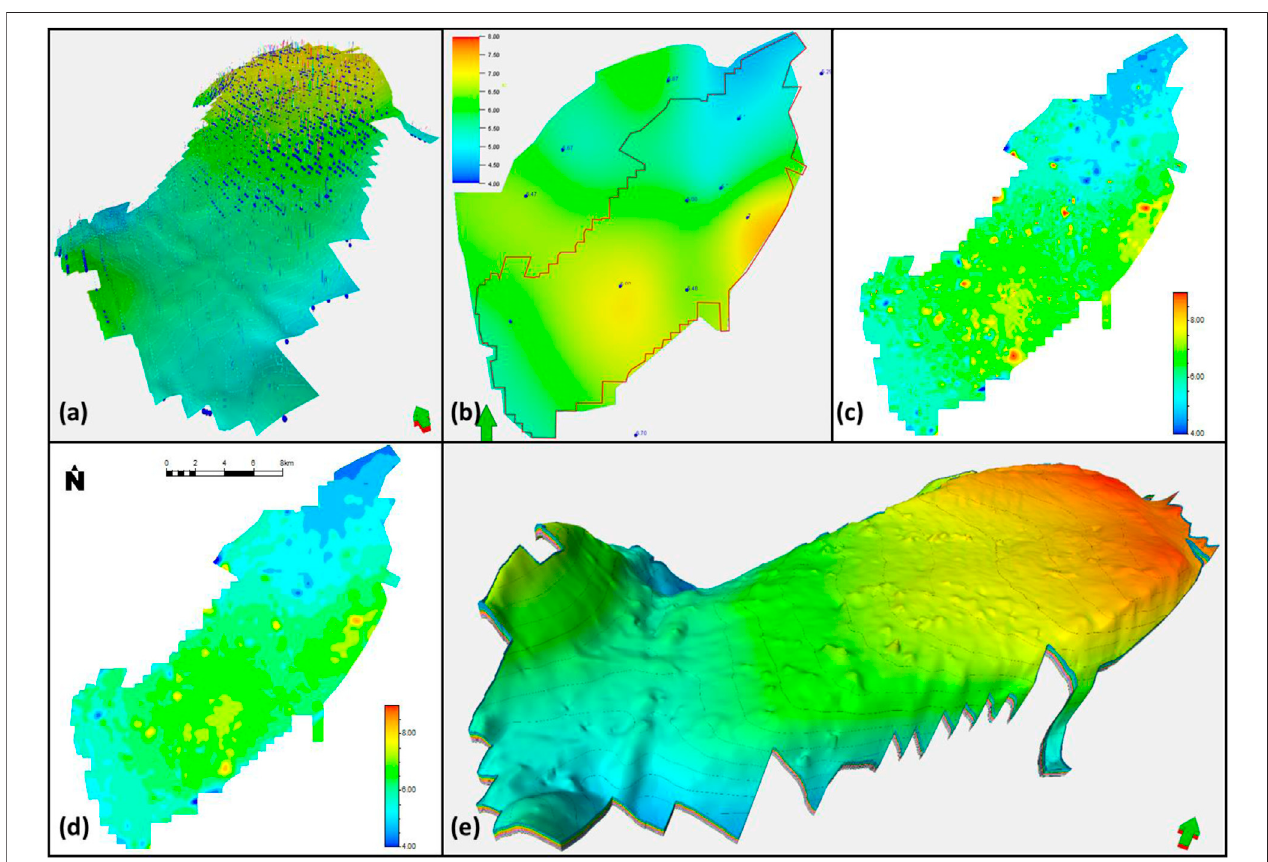
FIGURE 12 | (A) Seismic-interpreted structural map of the Wufeng base with the inferred Wufeng base elevation at PVW-As; (B) the Wufeng Formation TST contourmapgeneratedbyformationtopdatainverticalwells; (C) theWufengformationTSTcontourmapgeneratedbyformationtopdatainPVW-Asandverticalwells; (D) the smoothed Wufeng formation TST contour map; and (E) the 3D structural model of the Jiaoshiba area in the eastern Sichuan Basin.